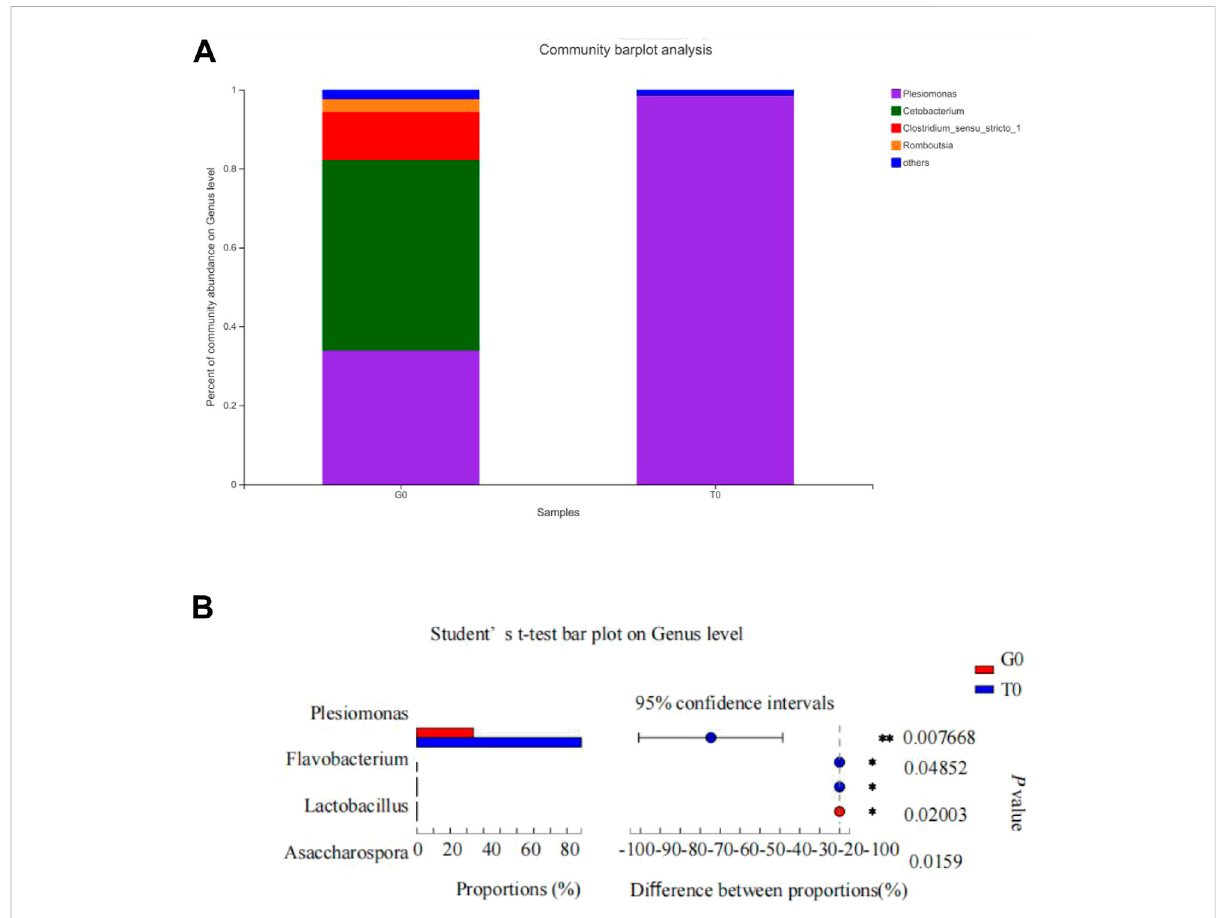
FIGURE 10 Intestinal microbiota composition. (A) Relative abundance of the intestinal microbiota at the genus level. (B) Differences in the relative abundance of the intestinal micro fl ora at the genus